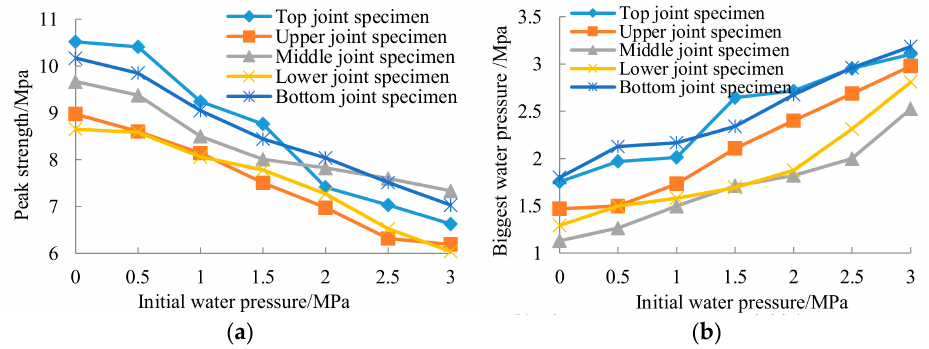
Figure 9. Influence of different initial water pressure and different joint locations on rock speci- mens with ( a ) peak strength vs. initial water pressure, and ( b ) biggest water pressure vs. initial water pressure.